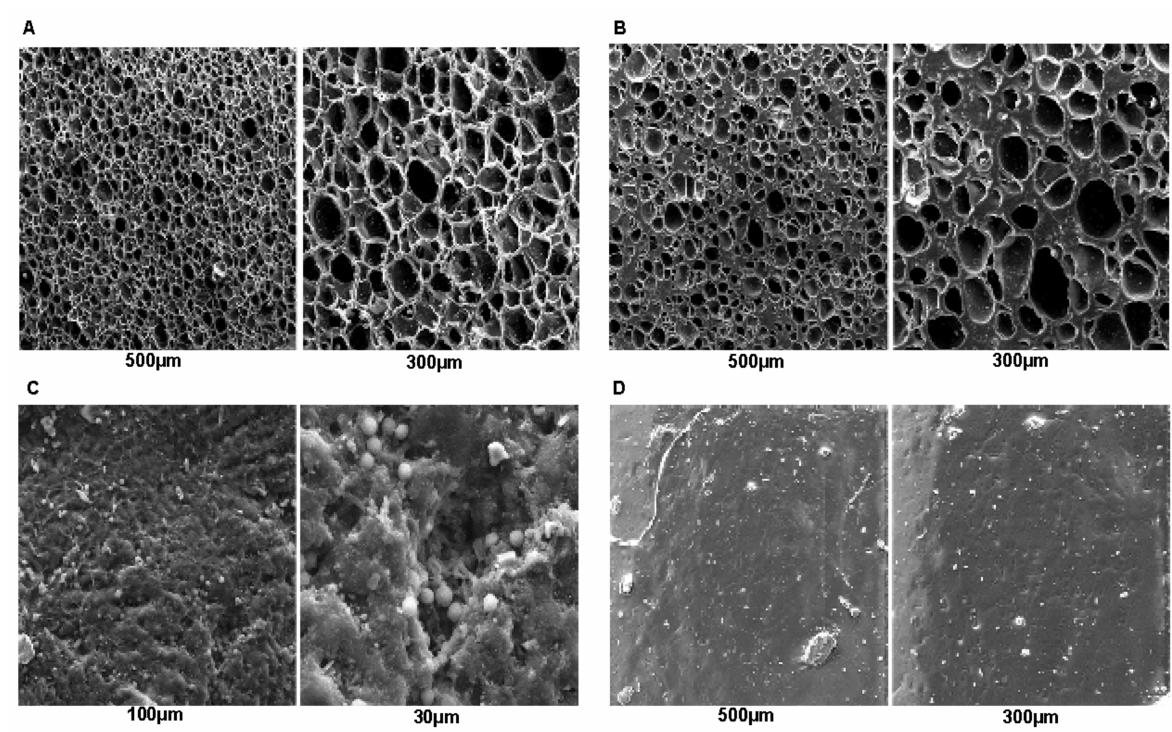
Figure 1. Morphology of the materials obtained by scanning electron microscopy. ( A ) Evapod; ( B ) Podadur; ( C ) latex; ( D ) silicone, in scans of 30, 100, 300, and 500 µ m.